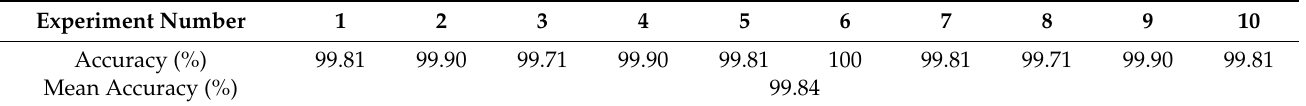
Table 7. Results of 10 experiments.